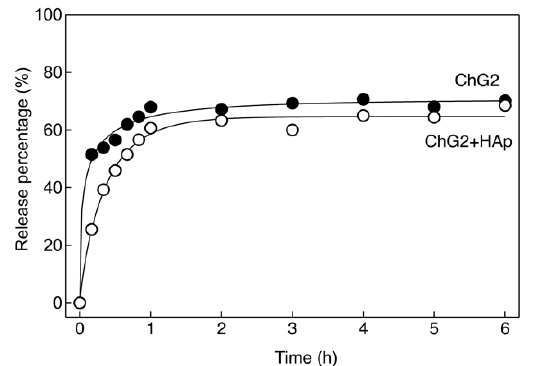
Figure 9. Release percentage of cytochrome C induced by the impregnation method from ChG2 and ChG2 + HAp as a function of time. Table 1. Weibull equation constants derived from Figure 9.